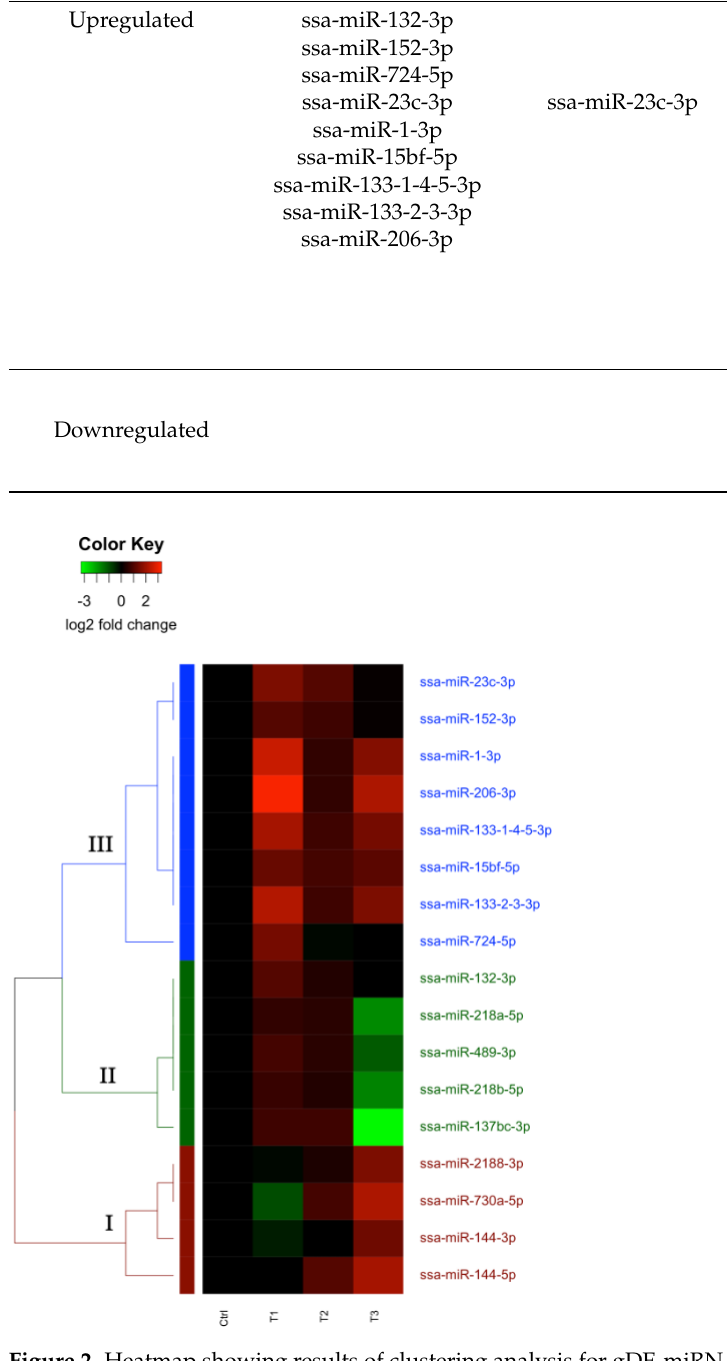
Figure 2. Heatmap showing results of clustering analysis for gDE-miRNAs based on changes in the HK samples grouped by sampling time point. Each line represents one miRNA, with the colour in each row representing the log2 fold change in abundance when compared to the control group. Major clusters of gDE-miRNAs are annotated as I (Cluster 1, red), II (Cluster 2, green), and III (Clus- ter 3, blue).